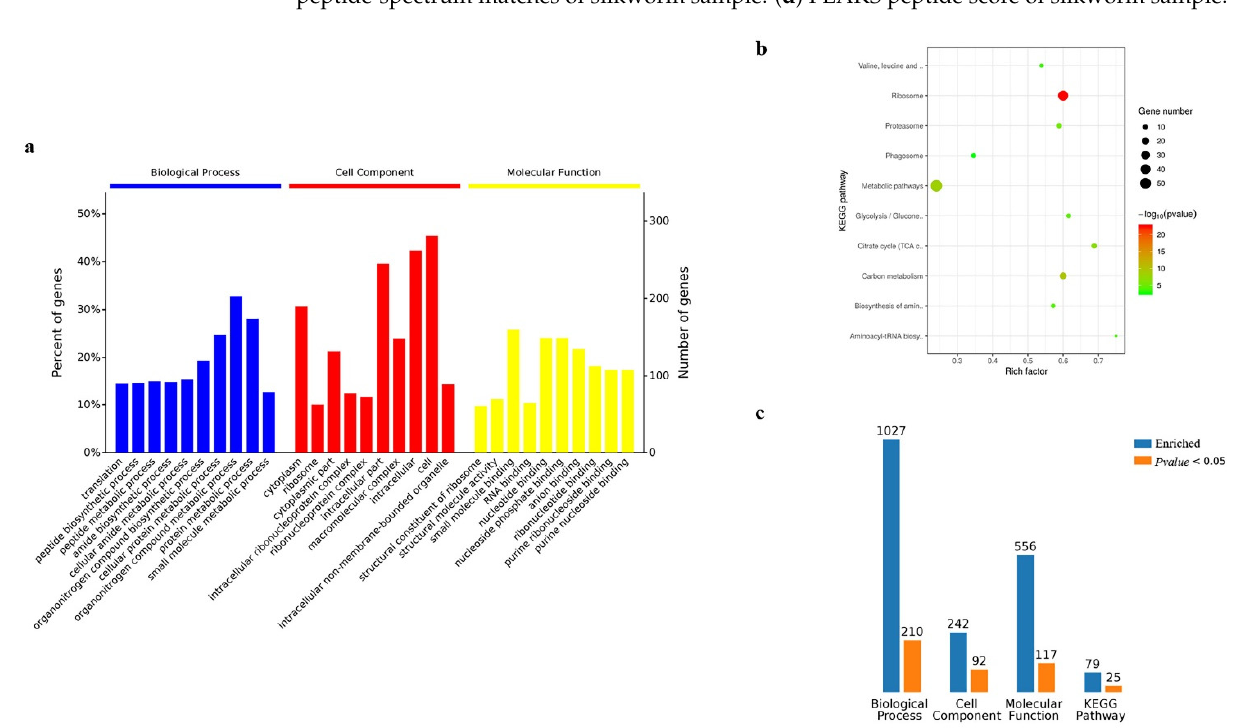
Figure 6. Analysis of Gene Ontology and KEGG for BmN sample. ( a ) Gene Ontology. ( b ) KEGG. ( c ) The summary of Gene Ontology and KRGG regarding enriched